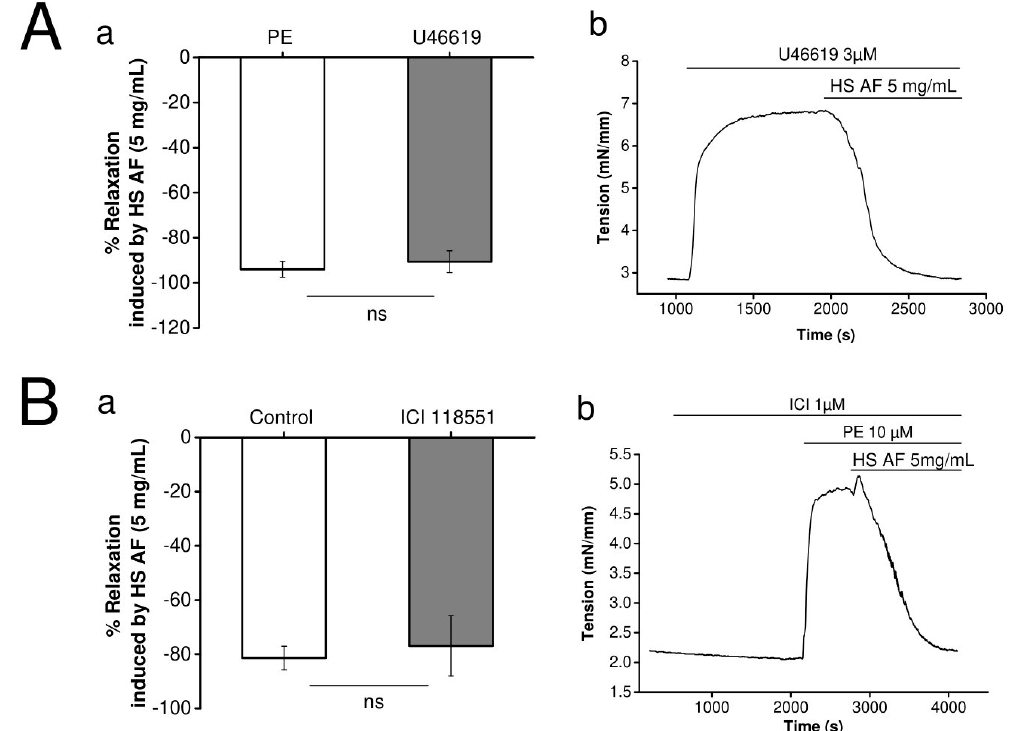
Figure 5. ( Aa ) Effect of 5 mg/mL HS AF on isolated Wistar rat MA rings in response to pre-contraction by 3 µM U46619 compared to the control. ( Ab ) Representative experiment trace. Values are expressed as mean ± SEM (n = 7/4 for control (PE + HS AF) and n = 8/4 for 3 µM U46619 + HS AF+). ( Ba ) Effect of 5 mg/mL HS AF with and without administration of 1 µM ICI 118,551 on isolated Wistar rat MA rings pre-contracted by 10 µM PE. MA rings were perfused using ICI 118551 for 20 min before pre-contraction. ( Bb ) Representative experimental trace. Values are expressed as mean ± SEM (n = 13/7 for control (PE + HS AF), n = 8/4 for 1µM ICI 118551 + (PE + HS AF)). Relaxation was calculated as a percentage of the initial contraction. Not statistically significant (ns).